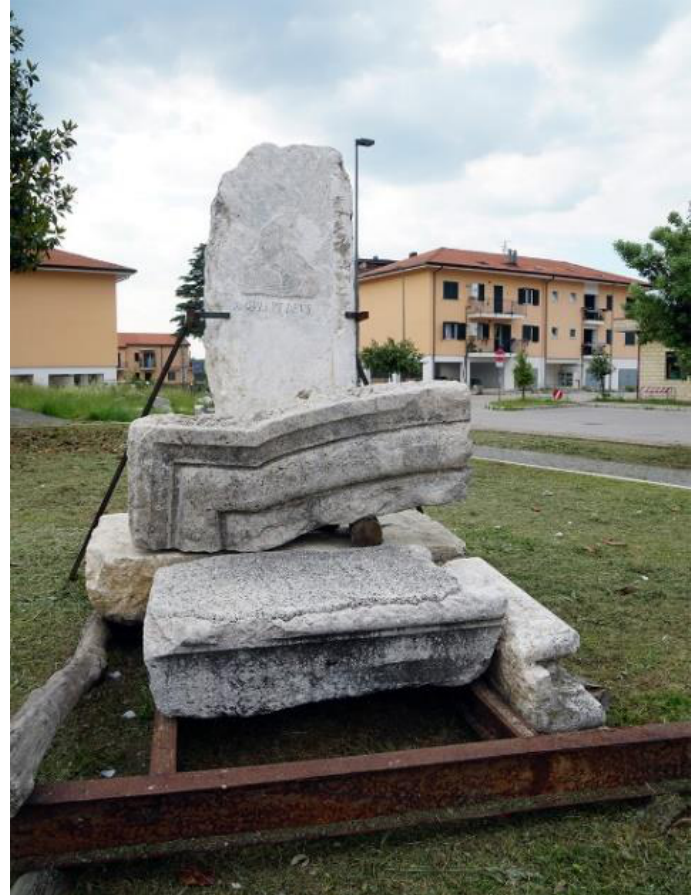
Figure 64. San Michele di Serino: the monument to the victims of the 1980 earthquake (photos by [35,36]).